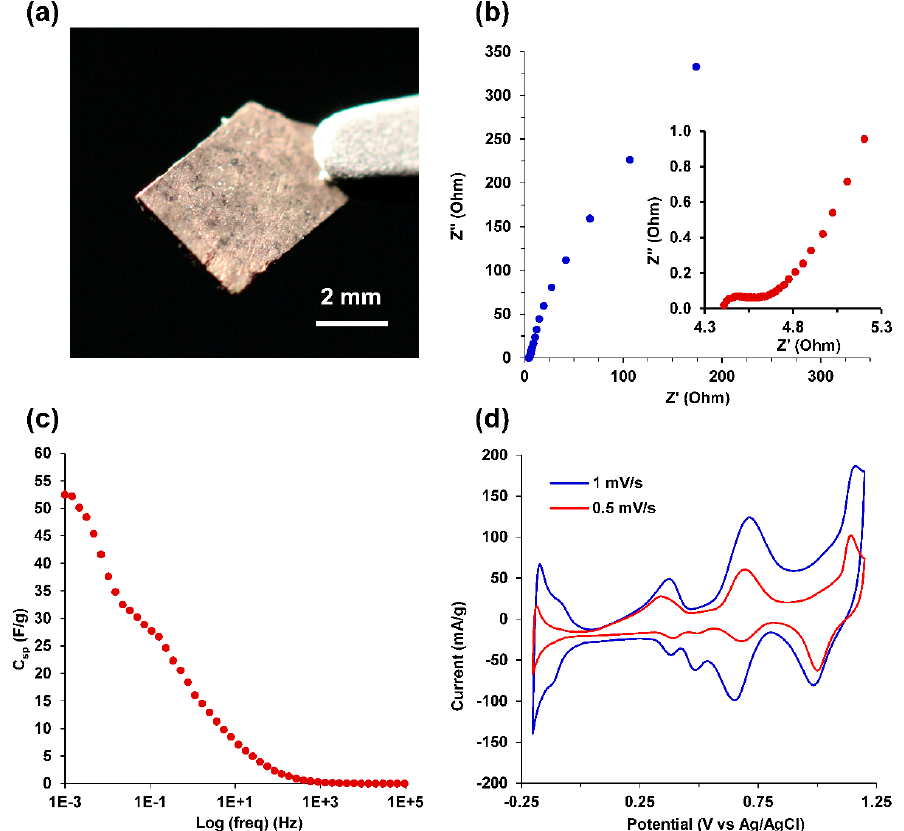
Figure 8. Electrochemical characterization of Au-Cu-Pd macrobeams. ( a ) Au-Cu-Pd porous film; ( b ) Potentiostatic electrochemical impedance spectroscopy (PEIS) in 0.5 M H 2 SO 4 at frequency range of 65 kHz to 1 mHz; (inset) high frequency EIS from 65 kHz to 1 Hz; ( c ) Specific capacitance, C sp (F/g), versus log(frequency) (Hz); ( d ) CV in 0.5 M H 2 SO 4 for 0.5 mV/s and 1 mV/s scan rates.